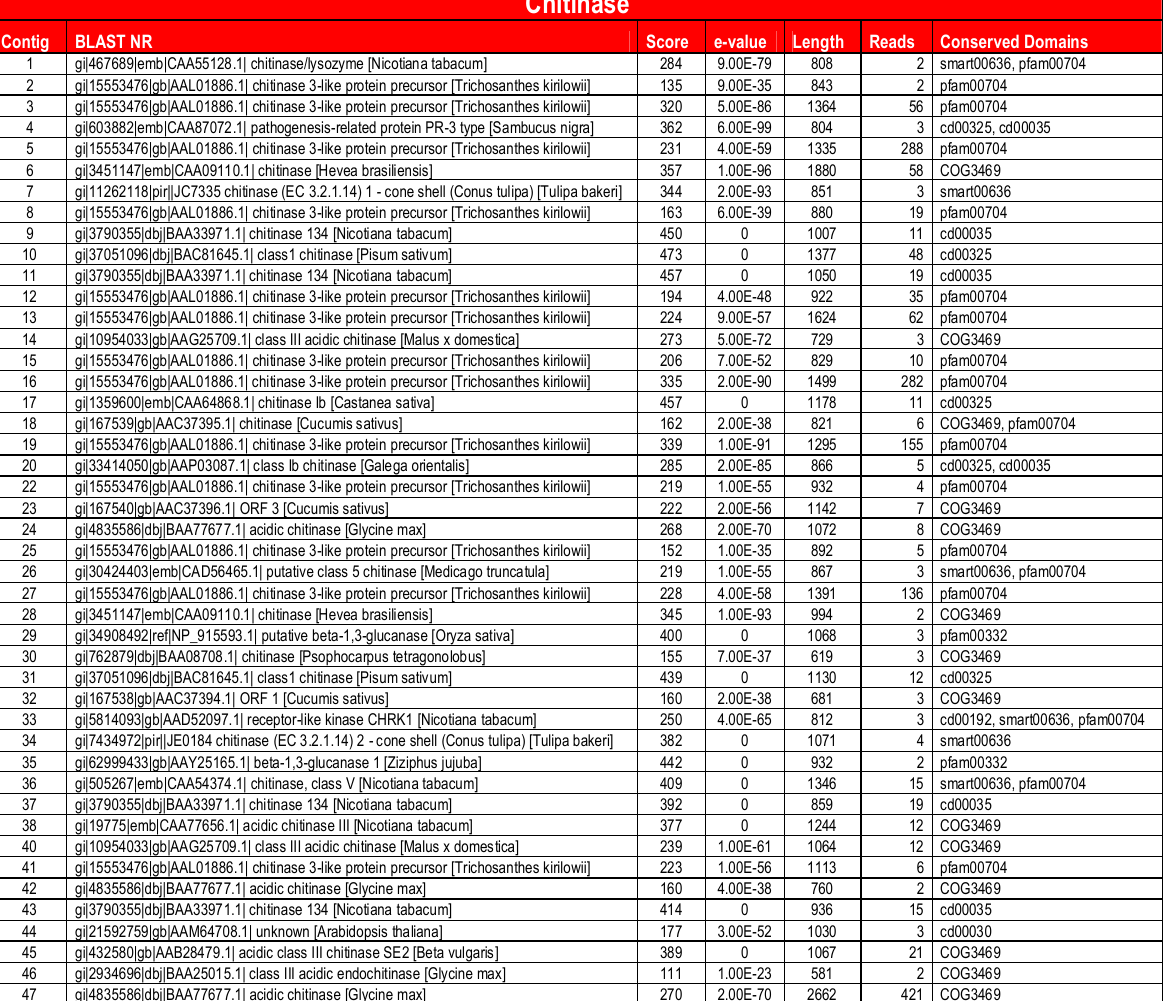
Table S5: EST-Contigs with e-value < e -20 and score > 100 obtained in the Project Chitinase, and their blast hit, score, e-value, size, number of reads, and conserved domains from putative